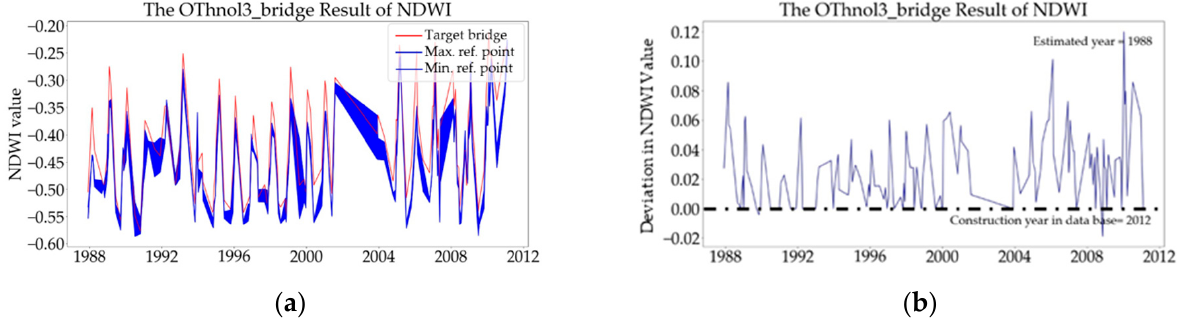
Figure 25. ( a ) NDWI results for the O Thnol 3 bridge from which it is estimated that the bridge was constructed in 1988 because there is an NDWI difference from the beginning of the analysis; ( b ) re-visualization of ( a ) showing the NDWI difference from 1988.